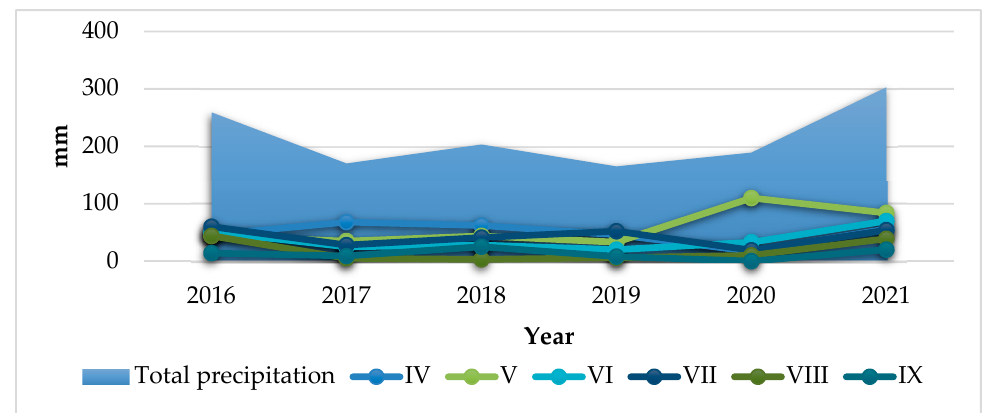
Figure 3. The amount of precipitation within the periods of April–September in 2016–2021. Source: own research results.